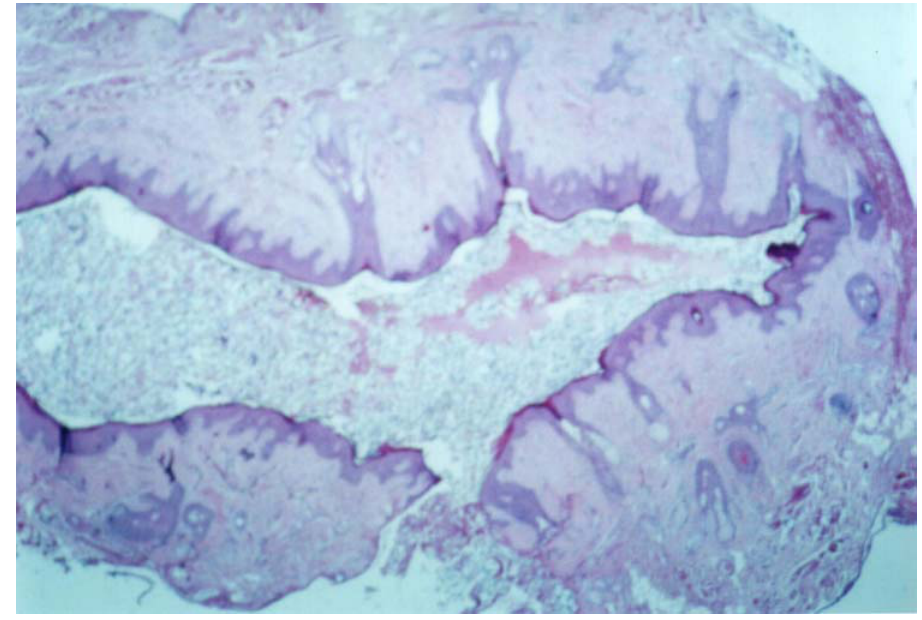
FIGURE 3. Low-power microscopy. The cystic lesion is lined by a stratified squamous epithelium. The lumen cyst is filled with a mixture of sebaceous and keratinized materials. Cyst capsule is composed of a narrow zone of compressed connective tissue with some dermal appendages. (H&E, original magnification X 25).